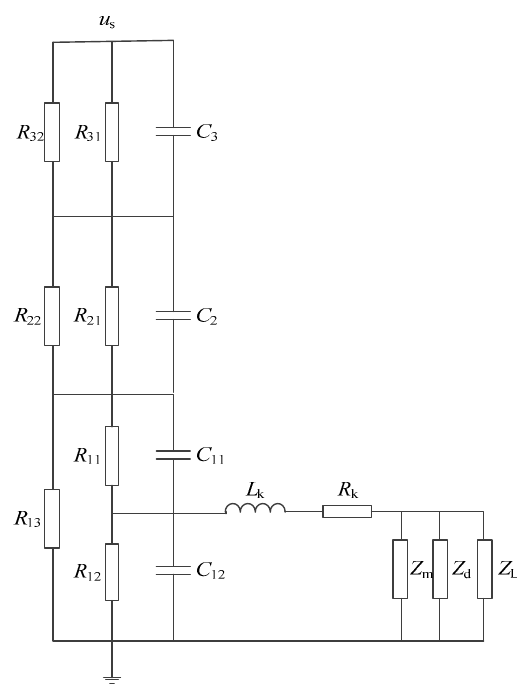
Figure 2. Proposed circuit model of a CVT.